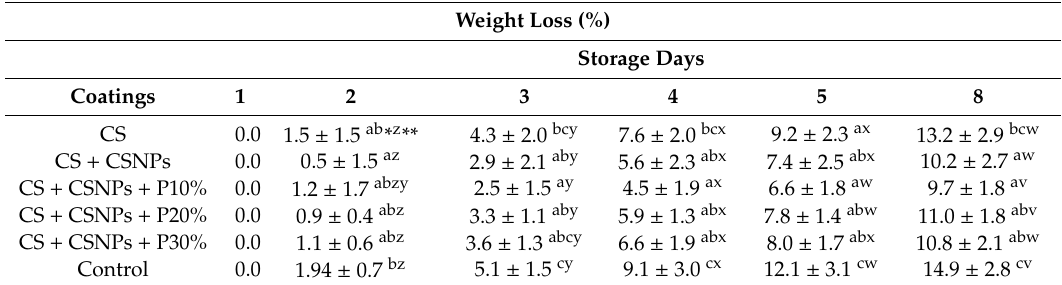
Table 1. Weight loss of strawberries treated with nanostructured chitosan coatings and propolis extract during eight days of storage.